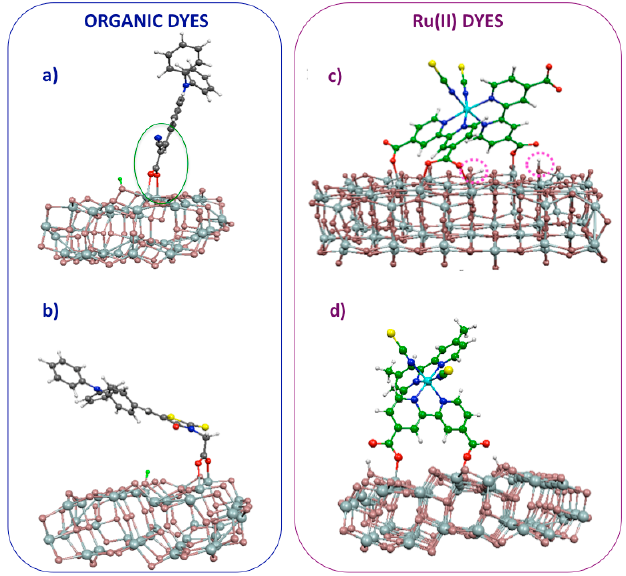
Figure 6. ( left ) Adsorption geometries of two differently-anchored organic dyes: a cyanoacrylic ( a ) and a 3-acetic rhodanine ( b ) acids anchored dyes; ( right ) adsorption of two prototypical Ru(II)-complexes with three points anchoring ( c ) and two monodentate points anchoring ( d ).